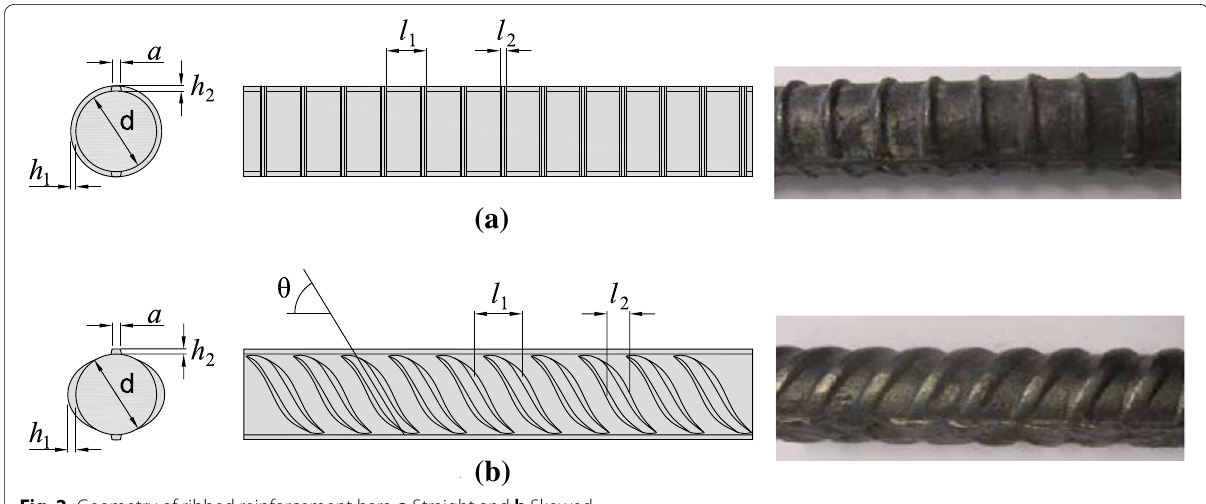
Fig. 2 Geometry of ribbed reinforcement bars. a Straight and b Skewed.